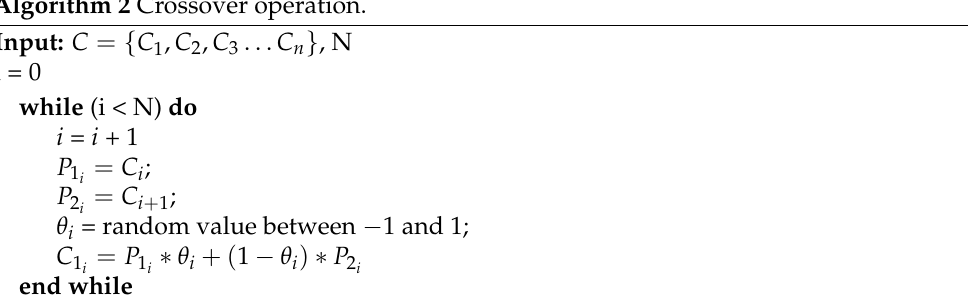
Algorithm 2 Crossover operation.